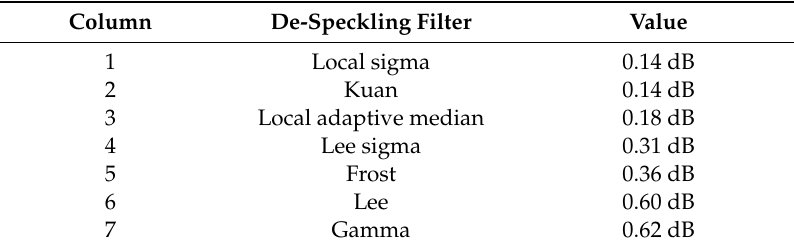
Figure 5. PSD of the residue HMS after the de-speckling procedure ( a ) Frost; ( b ) Gamma; ( c ) Kuan; ( d ) Lee; ( e ) Lee sigma; ( f ) Local adaptive median; ( g ) Local sigma; ( h ) Comparison of the residue HMS. Table 2. Residue HMS presence evaluation after de-speckling implementation.